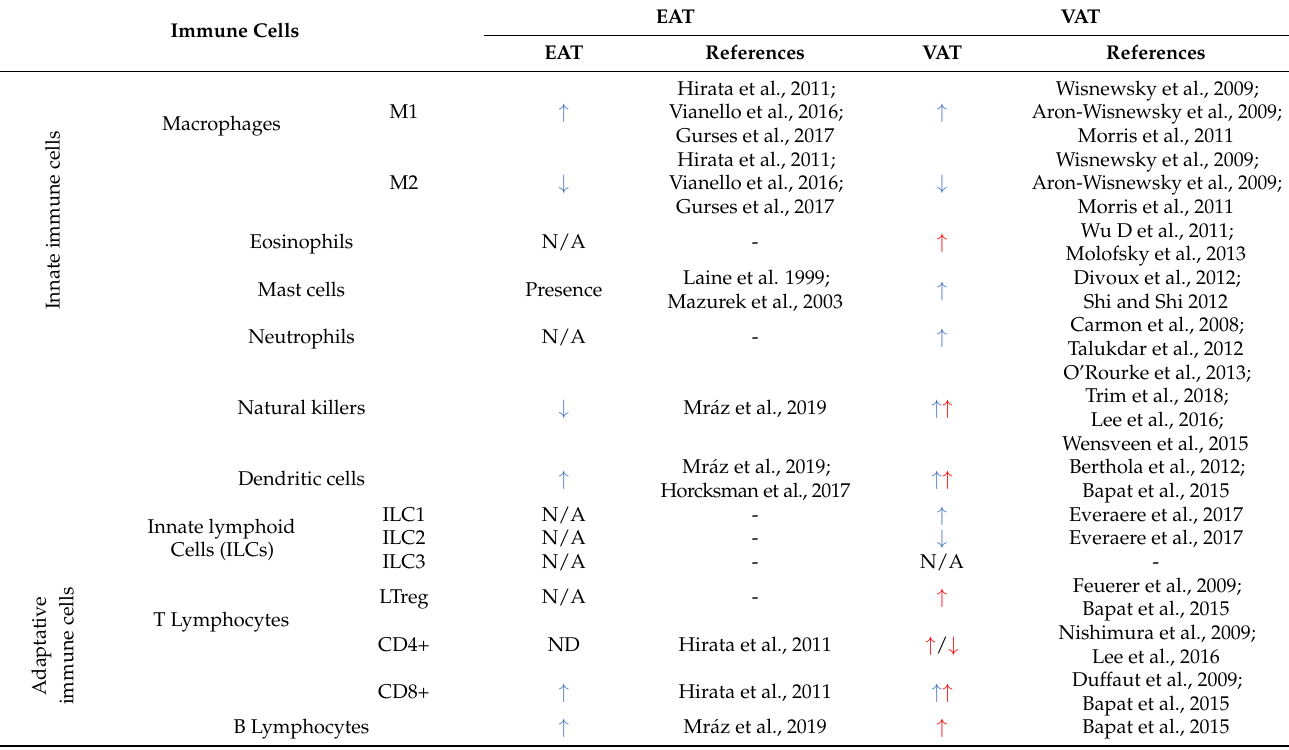
Table 1. Summary of the presence or absence of immune cell subtypes infiltration within adipose tissues in the context of obesity and related complications. Arrows represent an increase (up arrows) or decrease (down arrows) of cells in EAT or VAT compared to SAT referenced in mice (red) and human (blue). N/A: not applicable; ND: not